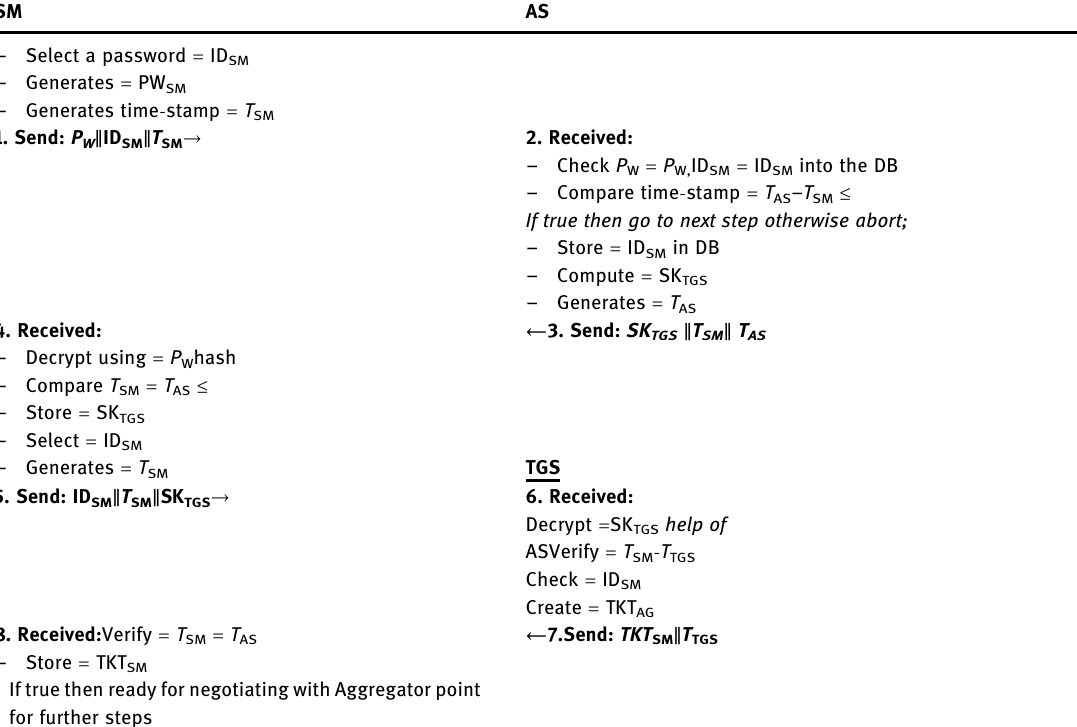
Table 2: Flow of registration process with authentication server SM